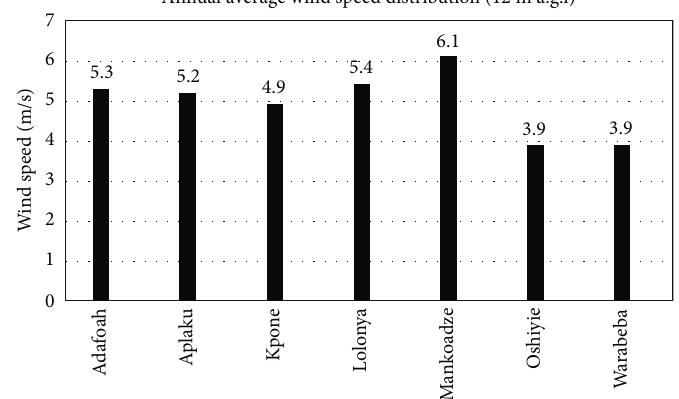
Figure 3: Annual average wind speeds data of the site over a monitored period (12 m a.g.l.)